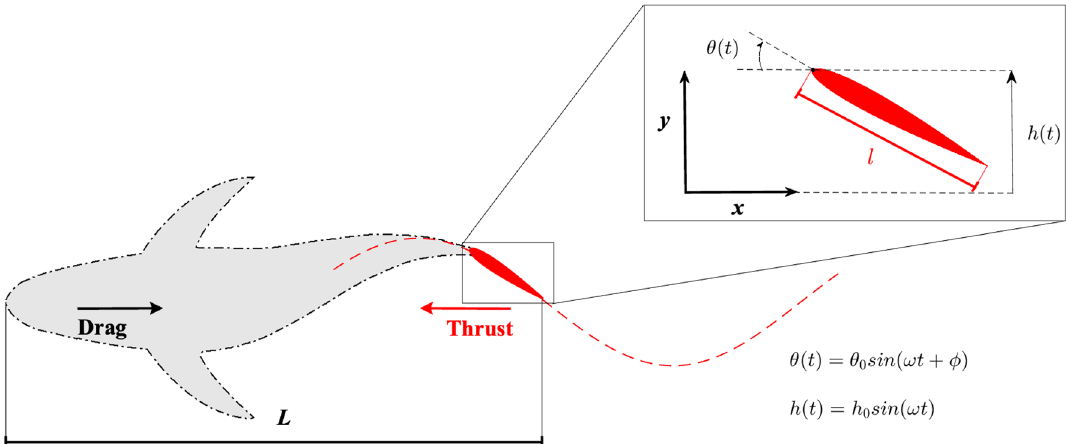
Figure 1. A cartoon for the virtual body (gray) and the tail propulsor (red) with a sketch of the exchanged forces and the oscillatory trajectory of the tail pivot point. The details of the flapping motion are reported in